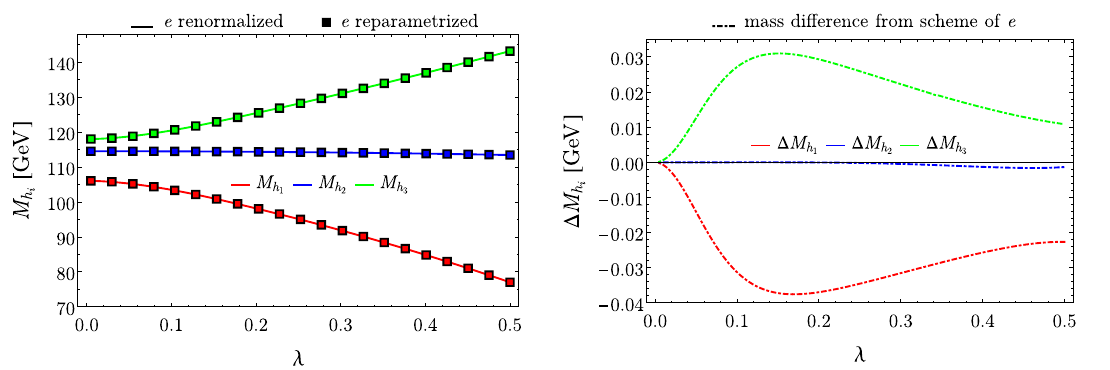
Fig. 3 Masses of the three lightest Higgs states h 1 ( red ), h 2 ( blue ), 2 M 1 = M 2 = M 3 / 5 = 0 . 5TeV. On the left-hand side, we present h 3 ( green ) in the CP -conserving limit for varying λ = 2 κ and our result ( solid line ) and that of [113] ( squares ). On the right-hand side, we plot the mass differences between these two codes, due to the the following input: tan β = 10, M H ± = 1TeV, μ eff = 125GeV, = 1 . 5TeV, A = 2TeV, A = 0 . 5TeV, A κ = − 70GeV, m ˜ scheme applied to the electric t f (cid:13)= t F